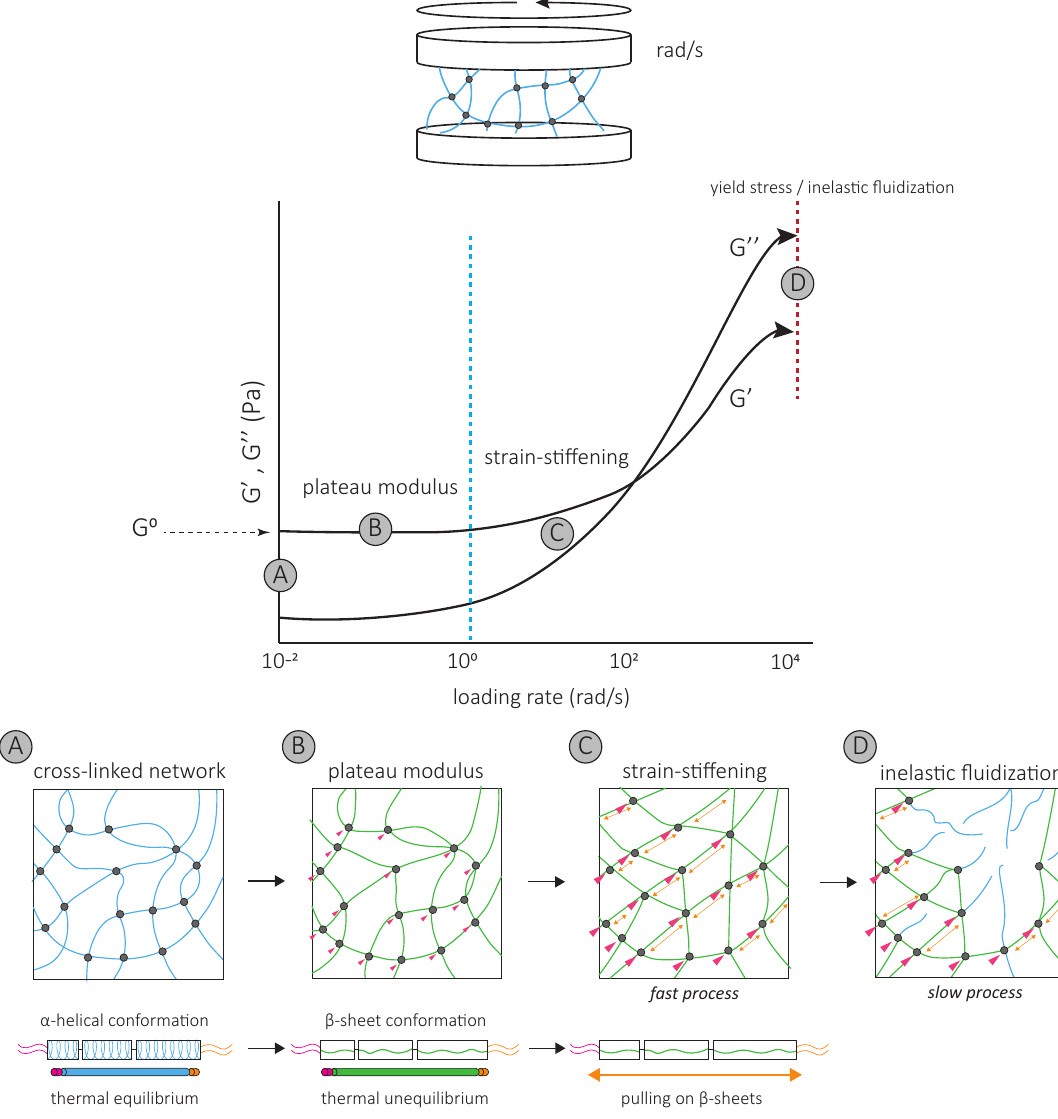
Figure 4. The mechanical properties of IF networks characterized by oscillatory shear rheology experiments of in vitro assembled networks ( A ). Deformation of the network using oscillatory shear rheology is achieved by network assembly between two plates and rotating one plate while the other is fixed, inducing a controlled deformation. Increasing the frequency of the rotations (rad/s) increases the stress and strain applied to the network. The response of the IF network to oscillatory shear is viscoelastic. Within the range of 0.01 and 10 rad/s, G’ and G” are independent of the oscillatory frequency, and a plateau is observed in both the G’ and G” curves. The corresponding G’ is called the plateau modulus or G 0 ( B ). Further increasing the stress by increasing the oscillatory shear frequency results in strain-stiffening of the network (( C ), start is indicated with blue dotted line). The network strain-stiffens up to a critical stress, the yield stress (( D ), red dotted line), at which the network ruptures. This corresponds to the start of inelastic fluidization. The plateau modulus results from attractive forces between filaments (grey circles) to maintain the stretched β -sheet conformation of single